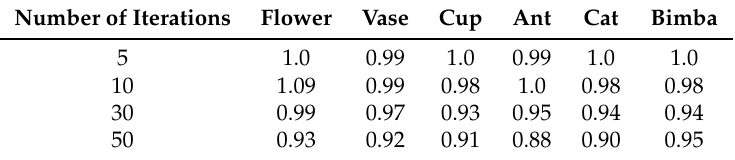
Table 6. Watermark robustness against Laplacian smoothing ( λ = 0.1) measured in terms of correlation.